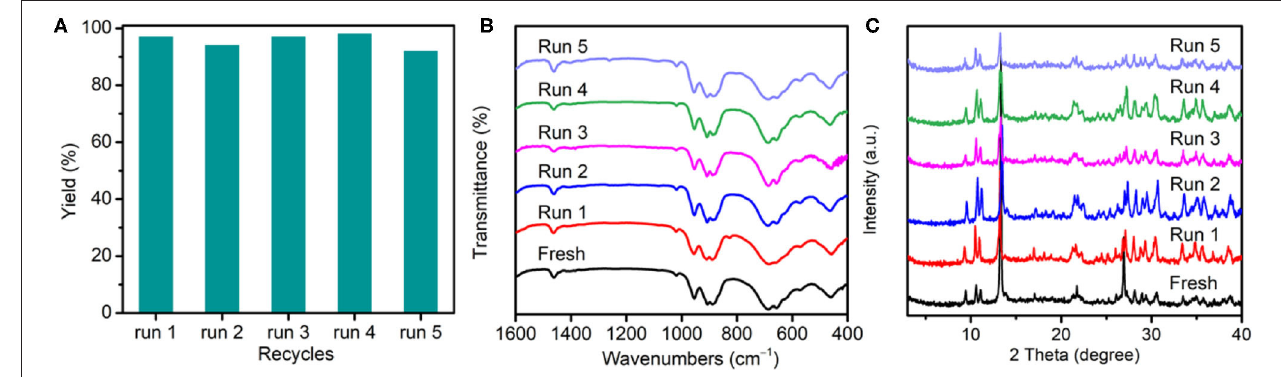
FIGURE 4 | (A) Reusability of {TbTeW 6 } catalyst. (B) Fourier-transform infrared spectra and (C) powder X-ray diffraction patterns of the activated {TbTeW 6 } catalyst before reaction and after each cycle. Reaction conditions: benzaldehyde (1 mmol), trimethylsilylcyanide (2 mmol), {TbTeW 6 } (2 mol%, relative to the benzaldehyde), naphthalene (0.75 mmol, internal standard) under Ar atmosphere, 45 ◦ C, 12h.